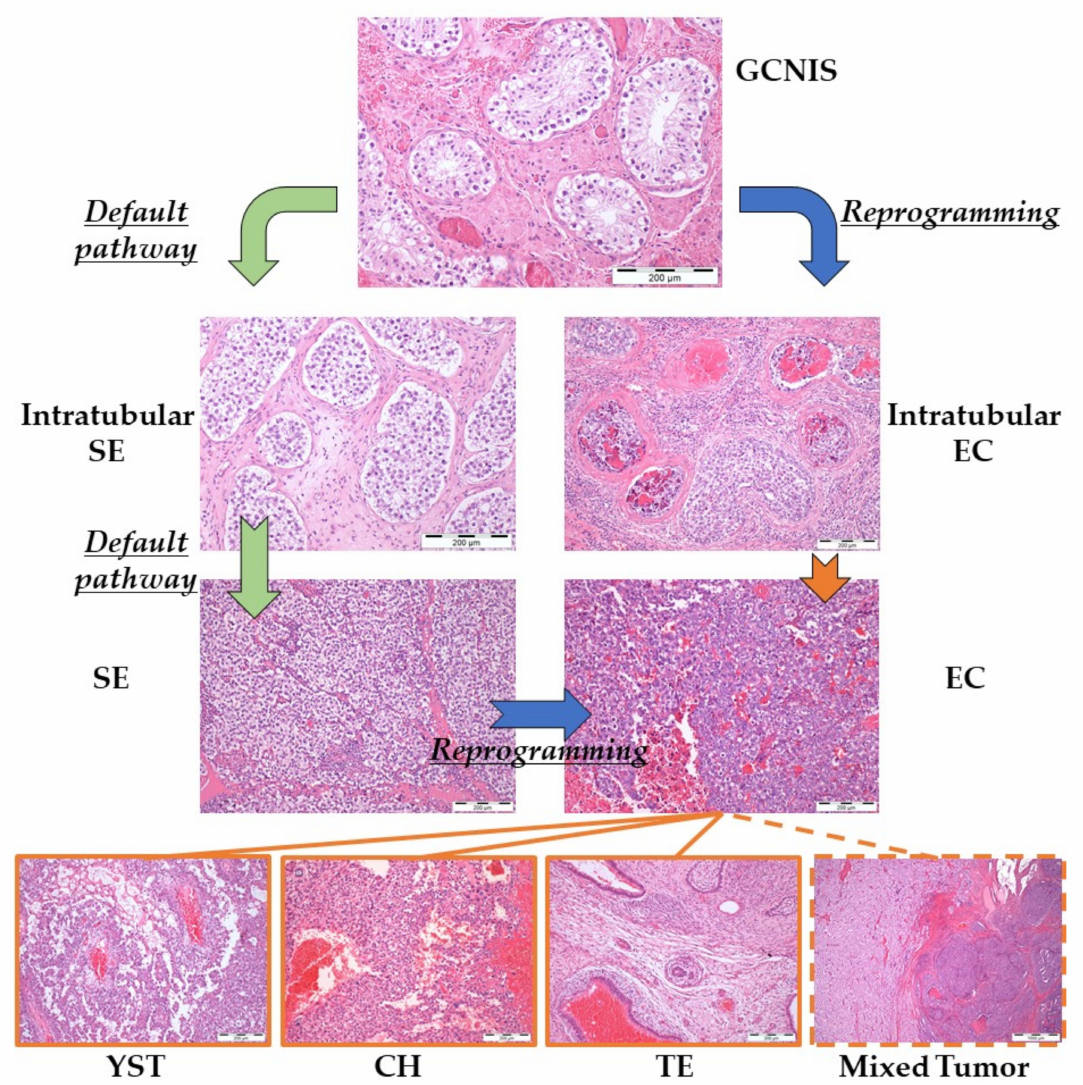
Figure 2. Pathogenesis of type II testicular germ cell tumors. Abbreviations: CH—choriocarcinoma; EC—embryonal carcinoma; GCNIS—germ cell neoplasia in situ; SE—seminoma; TE—teratoma; YST—yolk sac